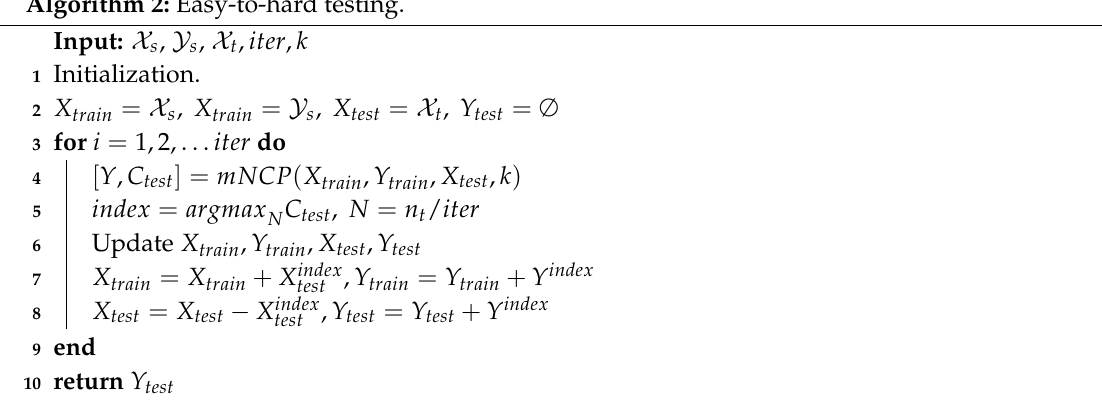
Algorithm 2: Easy-to-hard testing.